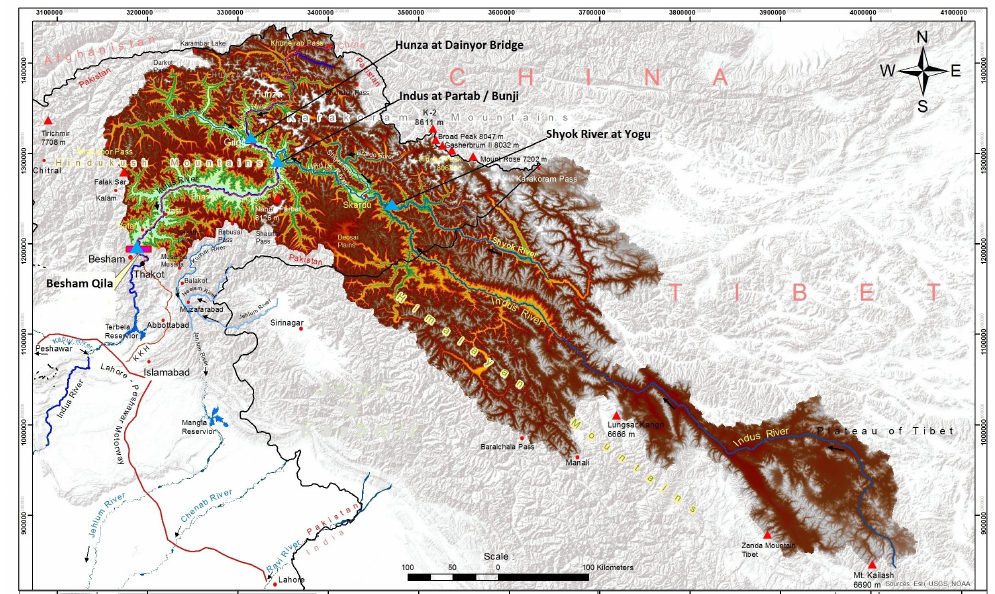
Figure 1. Demarcated Upper Indus catchment with the locations of four (4) gauging stations.